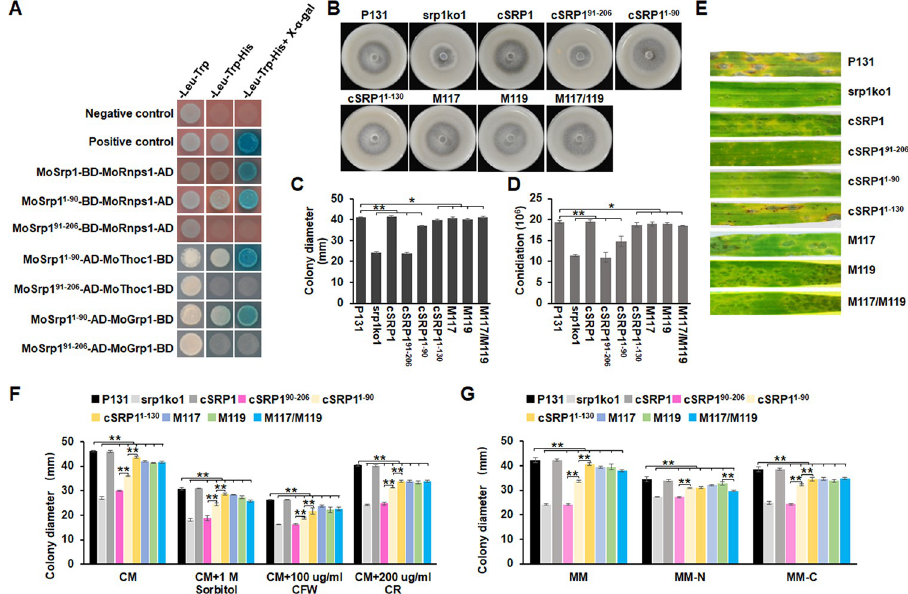
Fig 10. The RRM domain is essential to all the MoSrp1 functions but the SR region is important for stress responses. (A) The yeast two-hybrid assay showing that the interactions between N-terminus (1–90 aa) or the C- terminus (91–206 aa) of MoSrp1 and MoRnps1, MoGrp1, and MoThoc1. The interaction between AD-T and BD-Lam is used as the negative control, and the interaction between AD-T and BD-53 is used as the positive control. (B) The colonies formed on OTA plates at 5 dpi by the strains P131, srp1ko1, cSRP1 and srp1ko1 transformants expressing the N-terminal fragments cSRP1 1-90 (1–90 aa), cSRP1 1-130 (1–130 aa), the C-terminus fragment cSRP1 91-206 (91–206 aa), mutated MoSrp1 S117A (M117), mutated MoSrp1 S119A (M119), and mutated MoSrp1 S117AS119A (M117/119) of MoSrp1. (C) Statistics on colony diameters of the strains described in (B). (D) Conidia per petri dish produced on OTA plates by the strains described in (B). (E) Representative disease lesions on the leaves of susceptible barley sprayed with conidia of the strains described in (B), and photographed at 5 dpi. (F) Statistical analysis of colony growth reduction rates of the strains in (B) cultured on CM plates supplemented with different stress agents (1 M sorbitol, 100 μ g/ml CFW, or 200 μ g/ml CR) at 5 dpi. (G) Statistical analysis of colony growth reduction rates of the strains described in (B) under MM, MM-N, and MM-C conditions. The means and standard deviations in (C, D, F and G) were calculated based on three independent experiments with measuring three plates for each replicate. Asterisk marks significant difference between P131 and mutant strains using t -test (p < 0.05).